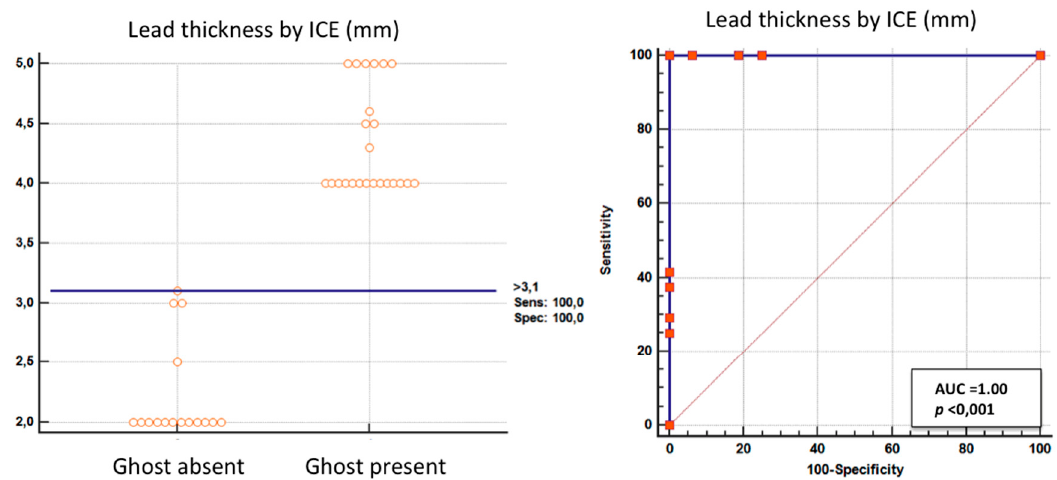
Figure 7. ROC curves. Left : bar graph showing the maximum individual measured lead thickness in patients with and without ghosts and the cuto ff value (solid horizontal line). Right : plot of sensitivity against 1-specificity of the measured lead thickness (ROC curves) in predicting a ghost. A—area under the curve.